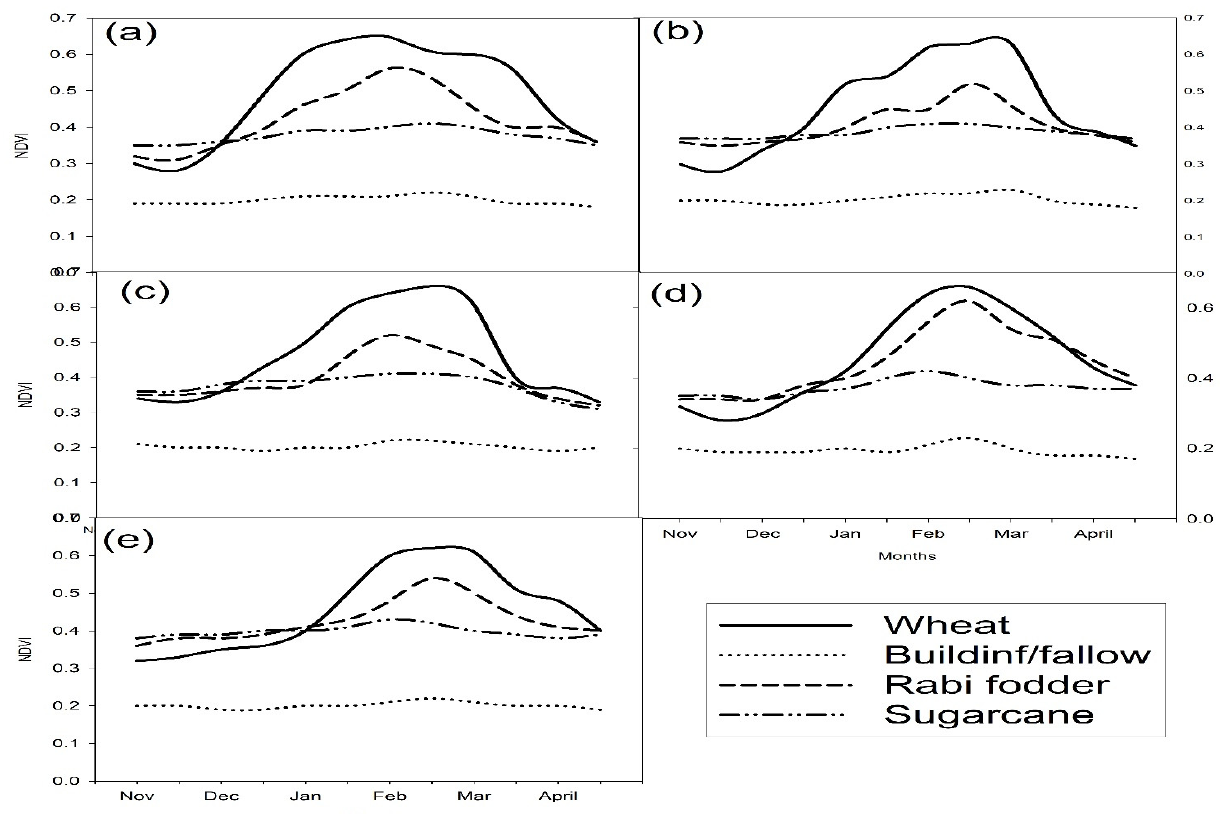
Figure 8. Mean NDVI seasonal changes for major crops during Rabi season ( a ) 1984, ( b ) 1993, ( c ) 2002, ( d ) 2011 and ( e ) 2020.